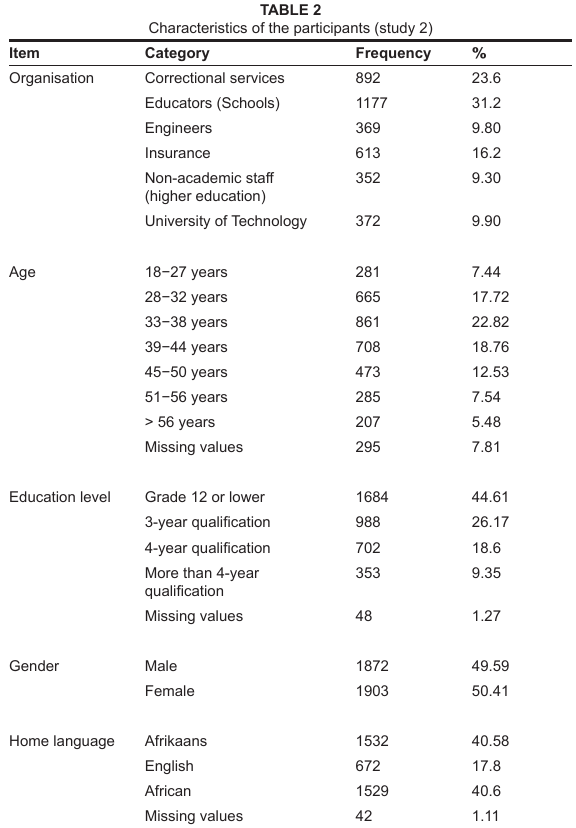
TABLE 2 Characteristics of the participants (study